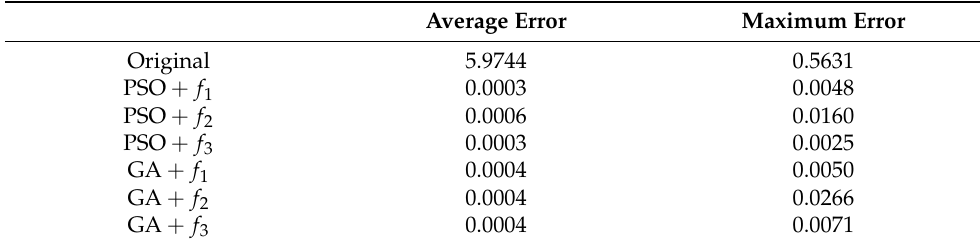
Figure 9. Comparison of the Mach number prediction. ( a ) Histogram of the prediction error of the Ma for the network optimized by the GA with f 1 . ( b ) Histogram of the prediction error of the Ma for the network optimized by the GA with f 2 . ( c ) Histogram of the prediction error of β for the network optimized by the GA with f 3 . ( d ) Histogram of the prediction error of the Ma for the network optimized by PSO with f . ( e ) Histogram of the prediction error of the Ma for the network optimized by PSO with f 2 . ( f ) Histogram of the prediction error of the Ma for the network optimized by PSO with f 3 . ( g ) Histogram of the prediction error of the Ma for the network without optimization. Table 4. Error comparison for Mach number prediction.